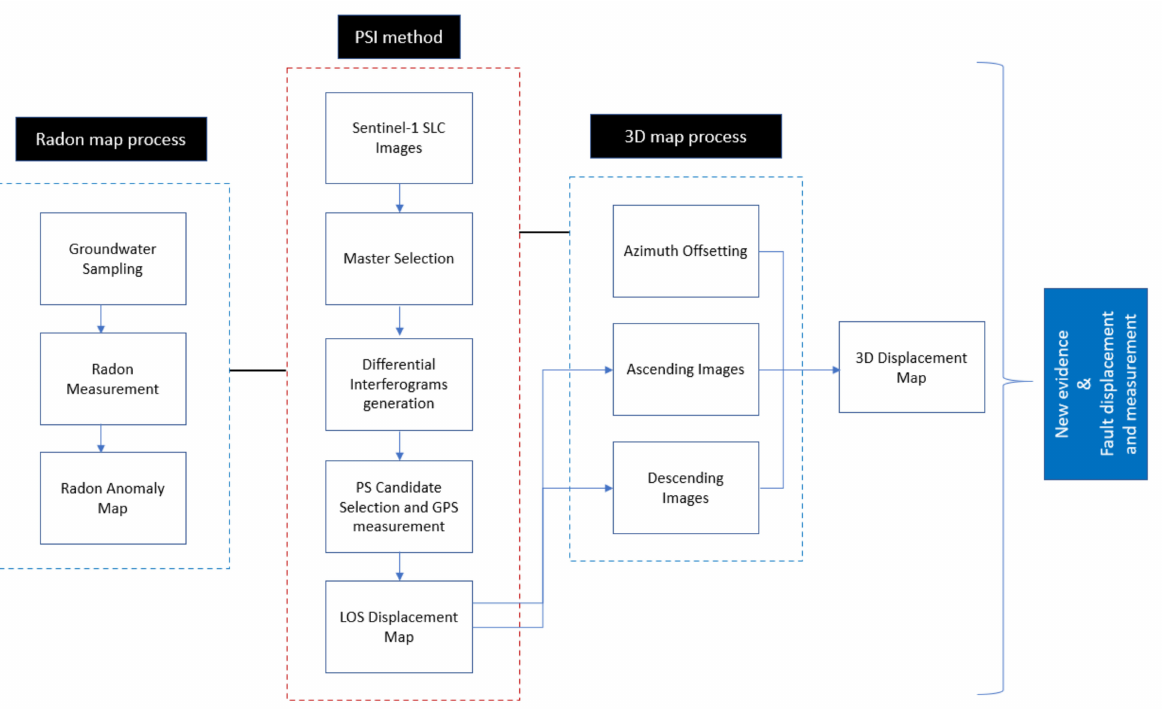
Figure 3. Flowchart of the research